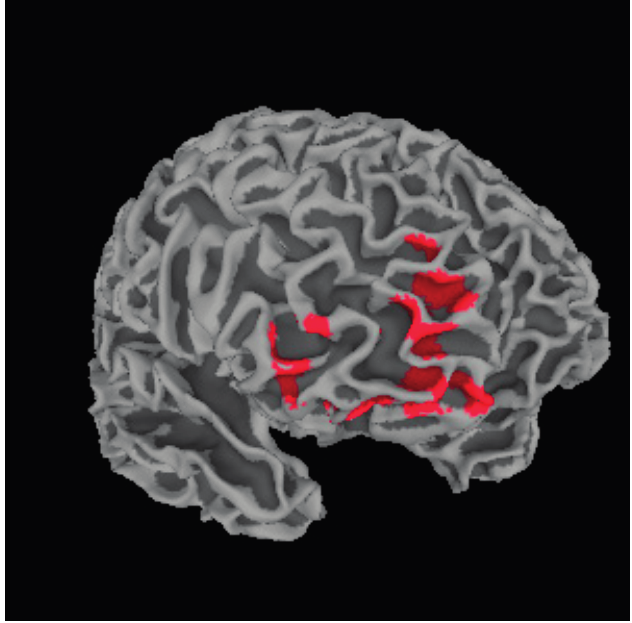
Figure 1. Illustration of significant positive relationship between the medial prefrontal cortex cluster and total metacognition score. Areas highlighted in red indicate regions of positive